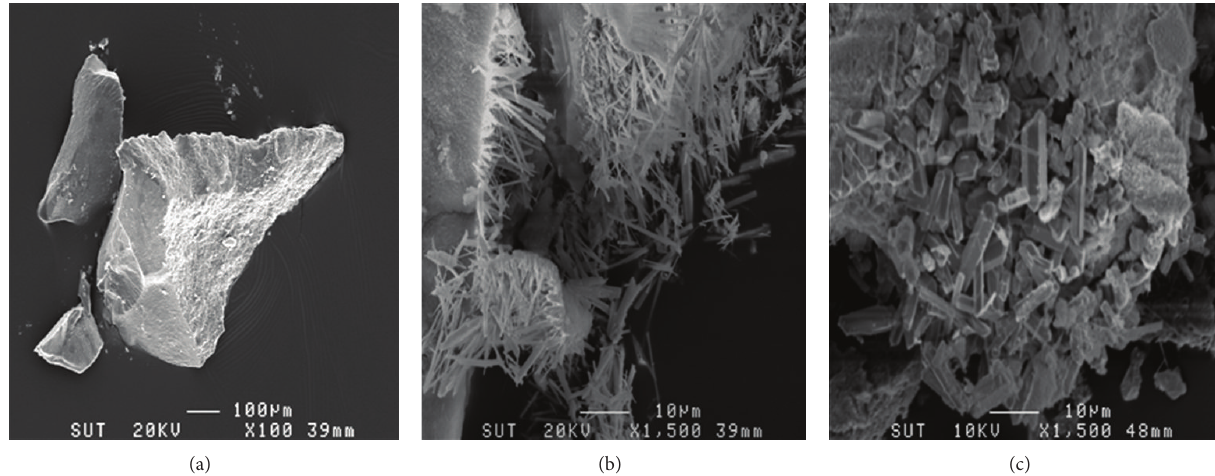
Figure 3: SEM images of (a) CaHAp before refluxing, (b) after refluxing in lead nitrate solution (917mg/L) for 24 h, and (c) after refluxing for 48 h.